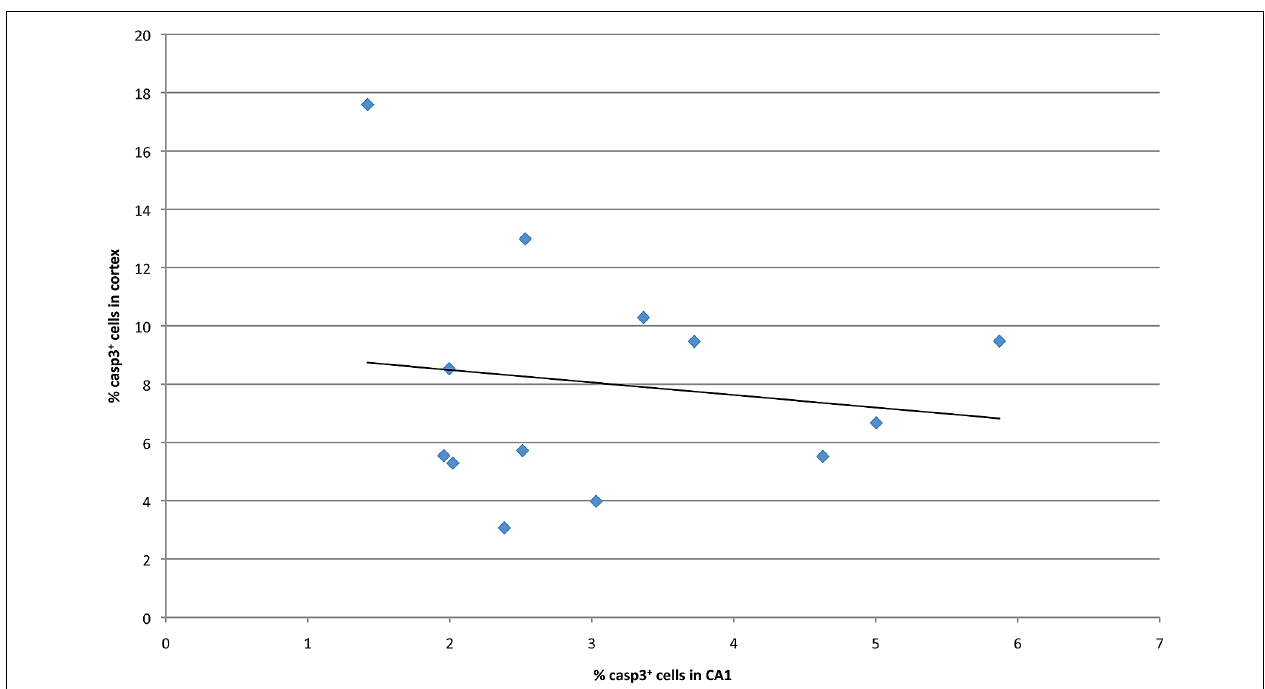
FIGURE 4 | Cell death in CA1 is plotted against averaged cell death in the cortex at P7 for all strains examined.